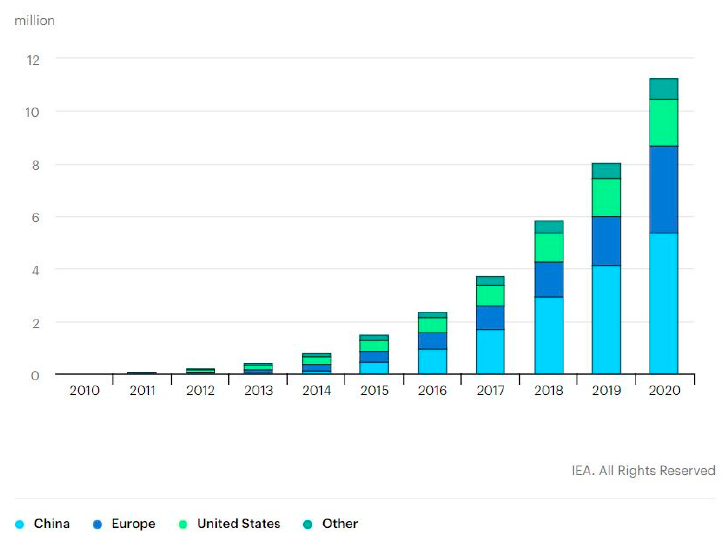
Figure 4. Graph highlighting the growth in the number of EVs globally from 2010 to 2020 [17].